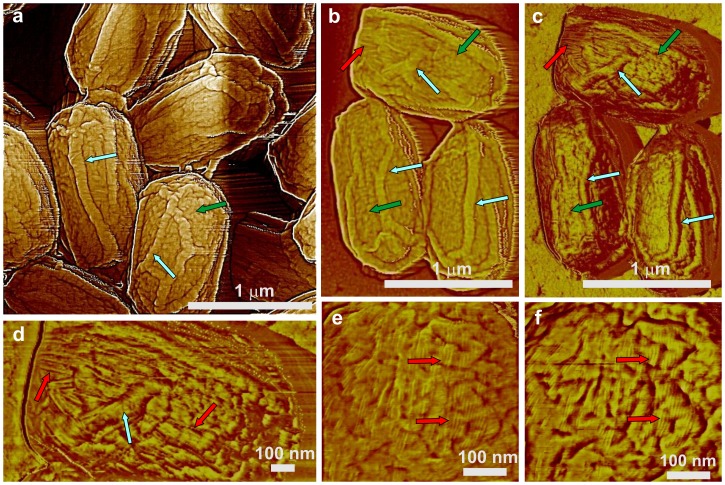
AFM images of decoated B. subtilis wild-type spores.Surface ridges extending along the entire length of spores are indicated with light blue arrows in height (a, b) and phase (c, d) images. Patches of rodlet structures are indicated with red arrows in (b–d). The green arrows in (a–c) indicate remnants of the amorphous outermost layer. High resolution height (e) and phase (f) images showing coincidental patches of rodlet structures denoted with red arrows.